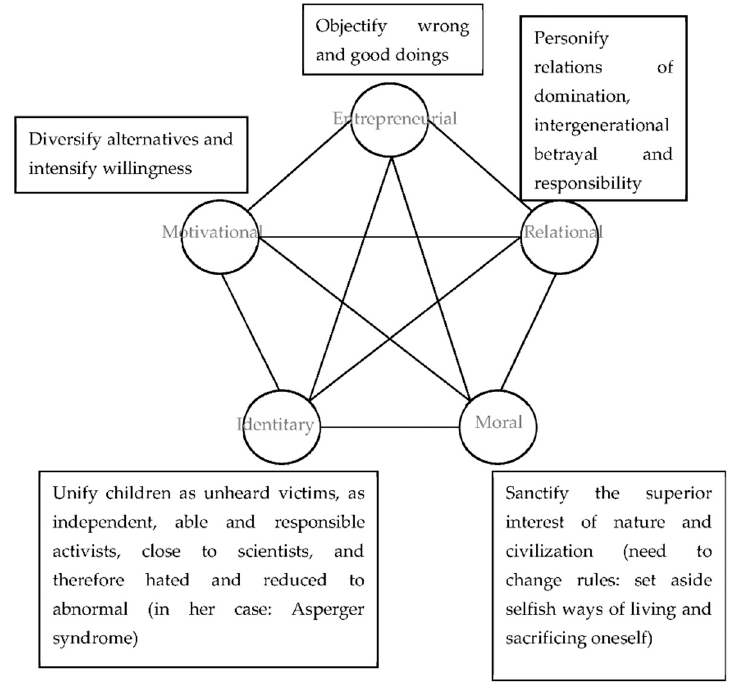
Figure 2. Vectors of agency of Greta Thunberg.